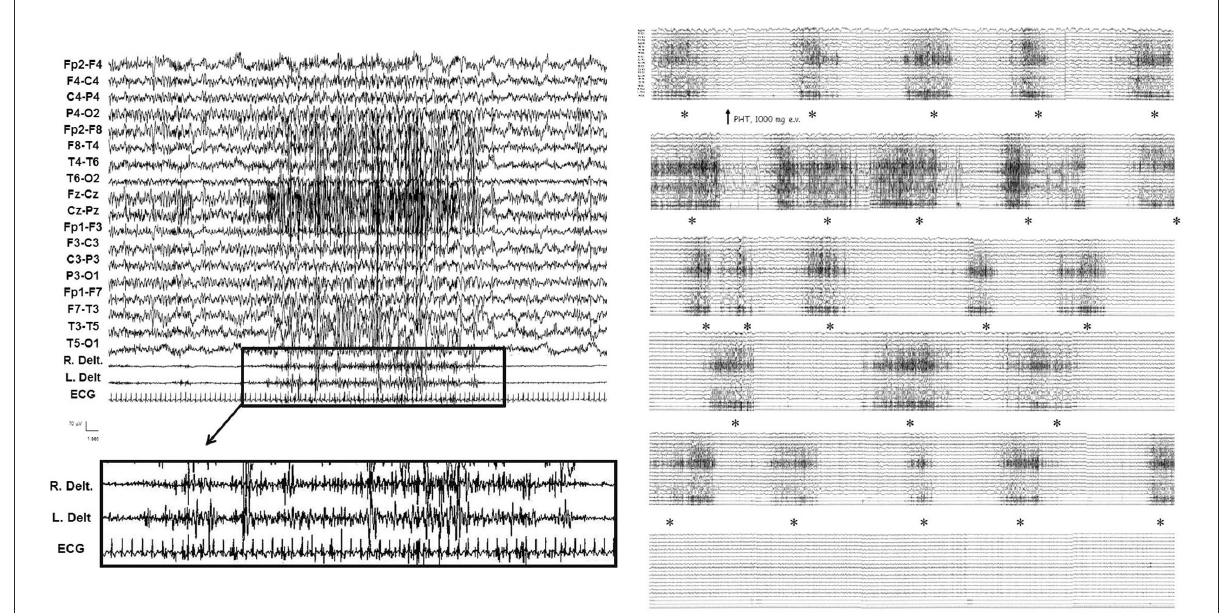
FIGURE2 Video-EEG/polygraphic features of myoclonic–tonic SE in patient 1 during the late stage. From the EEG/EMG point of view (see on the left), corresponding to the diffuse and fast paroxysms, myoclonic jerks mainly involving arms, superimposed on a tonic muscular enhancement, appeared; loss of awareness persisted between myoclonic–tonic events. IV diazepam 10mg, IV lacosamide 400mg, and IV levetiracetam 3,000mg were ineffective. Myoclonic–tonic SE resolved after IV phenytoin 1,000mg in 30min (see on the right). The asterisks indicate the gradual control of myoclonic–tonic episodes after IV